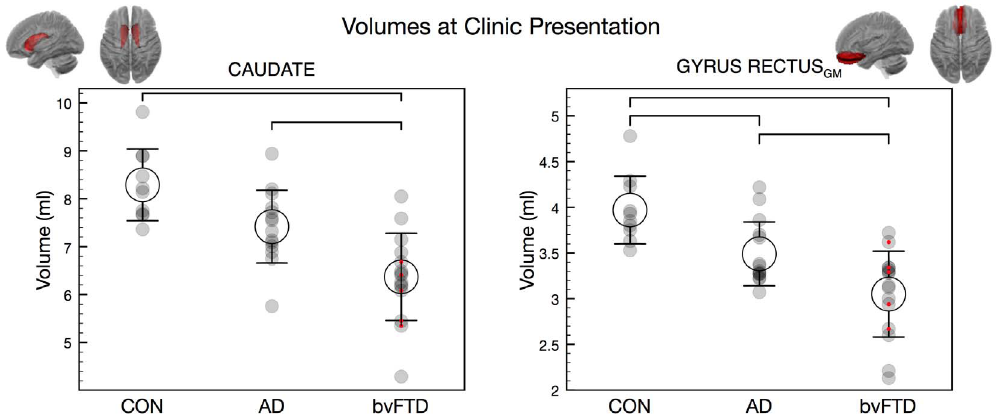
Figure 1. Volumes at clinic presentation (ml; Mean + / – 1 S.D.) of caudate and gyrus rectus grey matter. Brackets indicate significant group differences. Red dots indicate data from Freiburg. CON = control